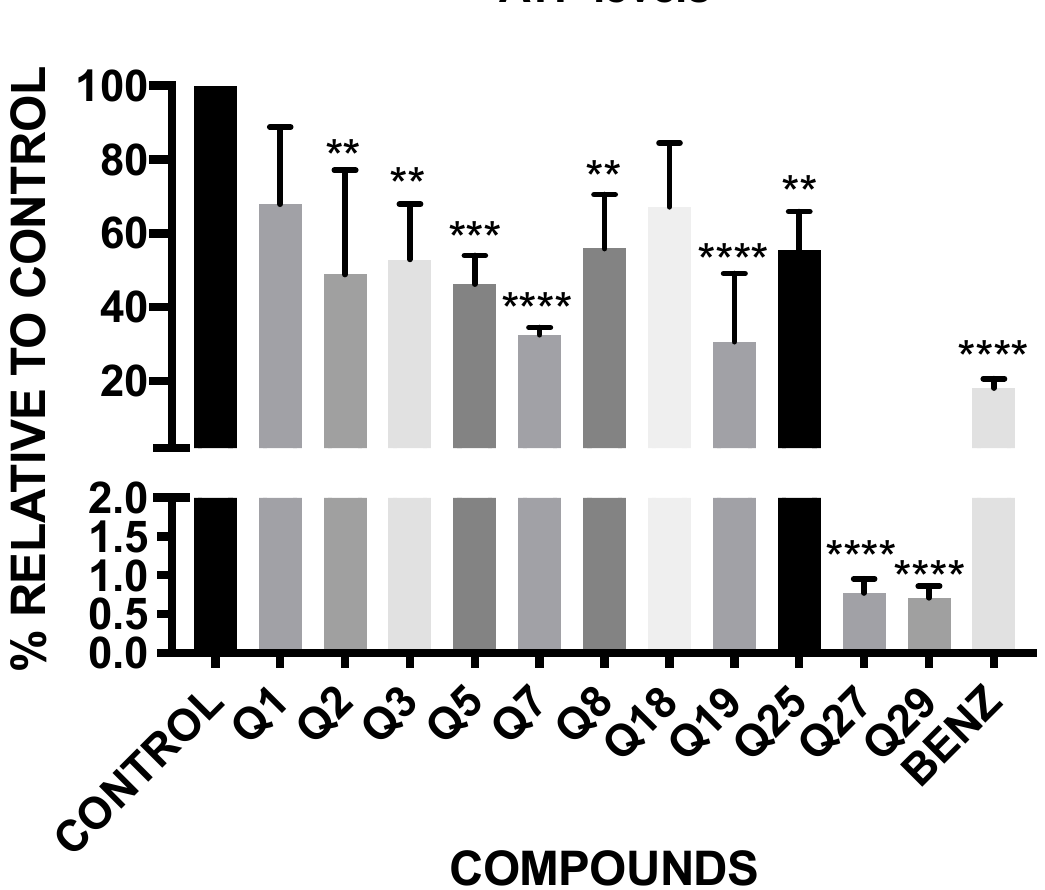
Figure 3. Percentage of ATP level relative to untreated control. Benz: benznidazole. A Tukey test with the GraphPad.PRISM ® 7.0a soft-ware test was carried out to test the statistical differences between means. ( p < 0.05 [**]; p < 0.001 [***]; p < 0.0001 [****]).